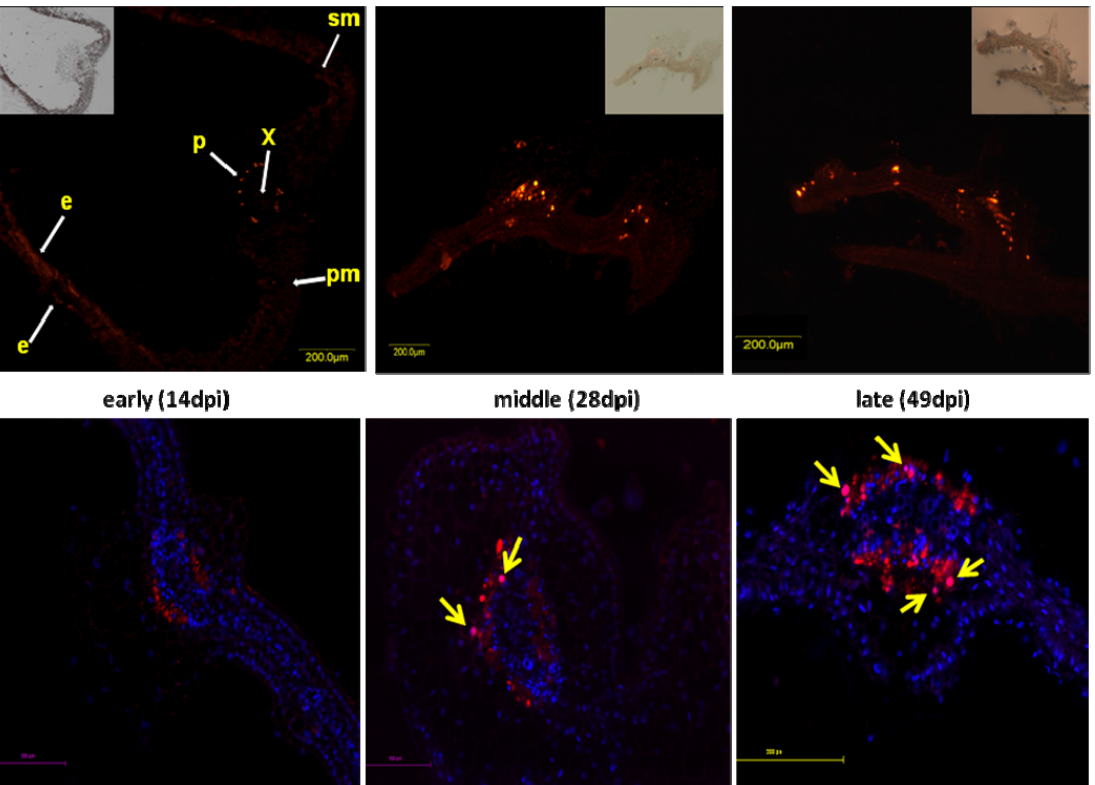
Figure 2. Localization of coat protein (CP) in cross-sections of midribs of infected leaves from susceptible tomatoes. A primary anti-CP antibody and Cy3-labeled secondary antibody (appears as red) were used for fluorescence microscopy. Nuclei are DAPI stained and appear as blue. CP localized in nuclei appears as pink (arrows). Inserts: composite image of fluorescent and transmission microscope settings, e: epidermis, p: phloem, pm: palisade mesophyll, sm: spongy mesophyll, x: xylem. CP associated fluorescence 14 (early), 28 (middle), and 49 (late) days after inoculation (dpi). Bars: 100 µm (upper panel) and 100, 200 µm (lower